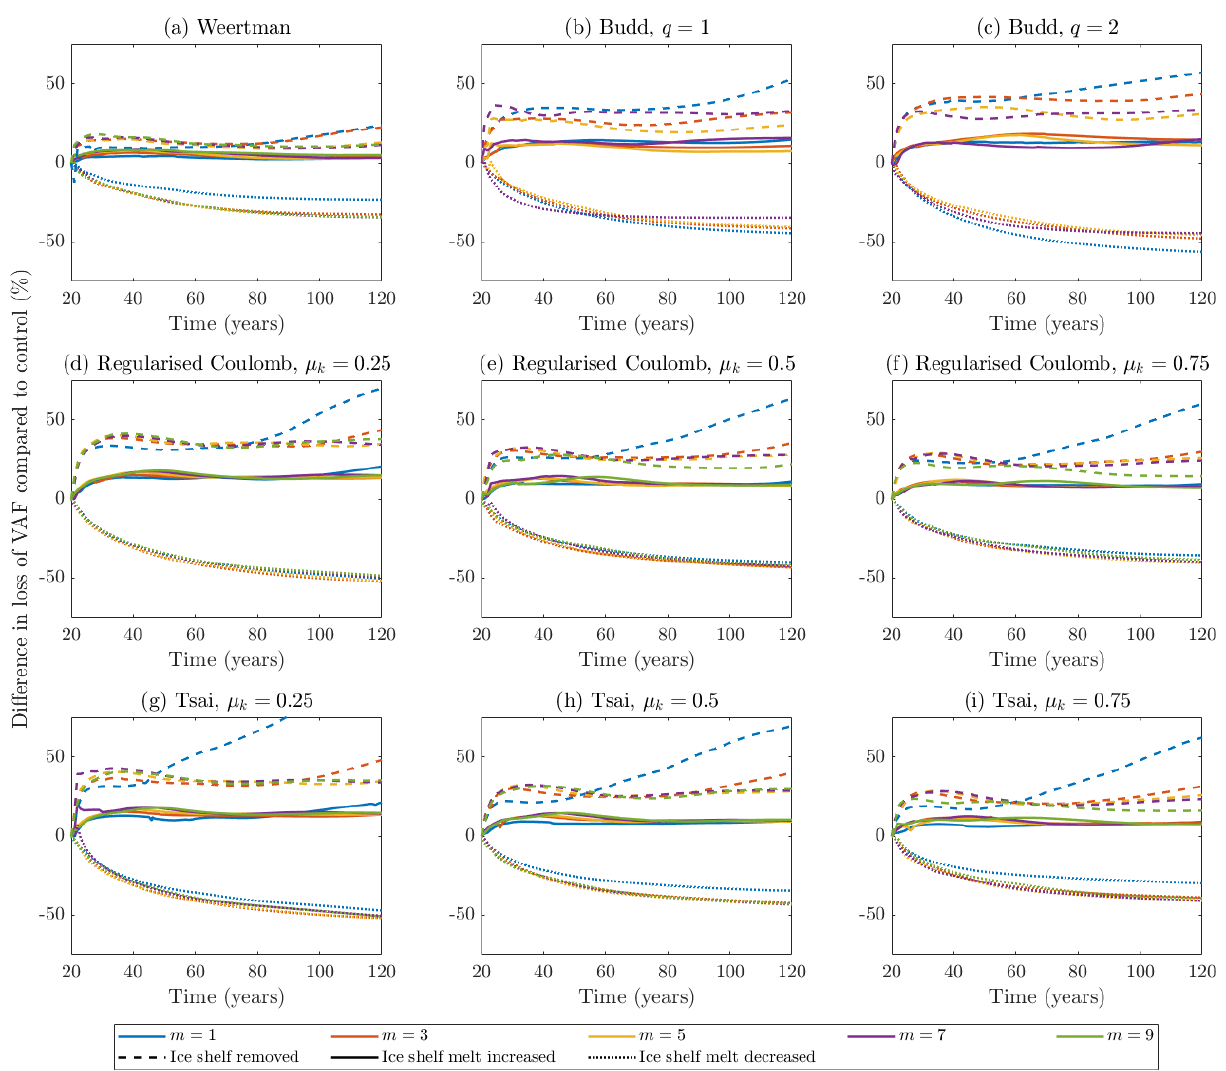
Figure 3. Additional VAF loss compared to the control branch after the changes in forcing are introduced for the entire ensemble of sliding law and parameter